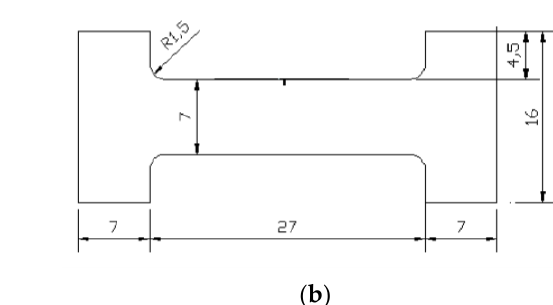
Figure 4 . In-situ SEM fatigue of TC21 titanium alloy: ( a ) In-situ fatigue loading device; ( b ) Dimensions of in-situ fatigue specimen.